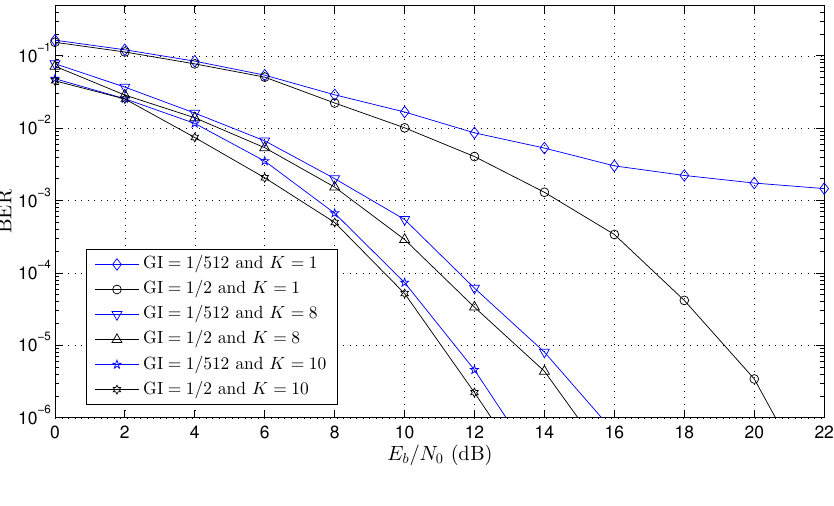
Figure 8. BER performance curve for Channel 3 (see Table